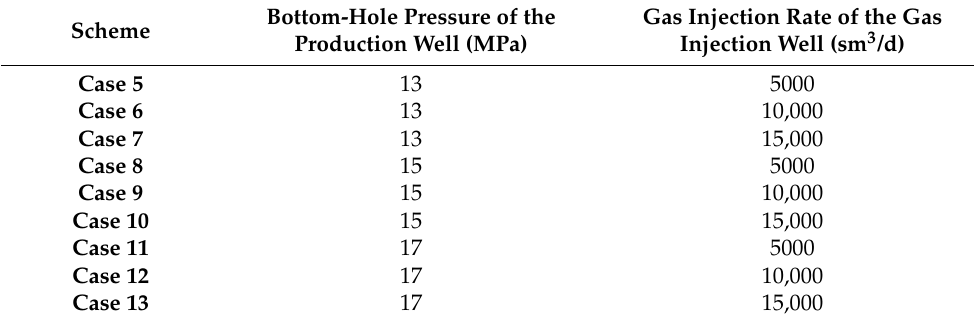
Table 6. Design table of the injection-production scheme.